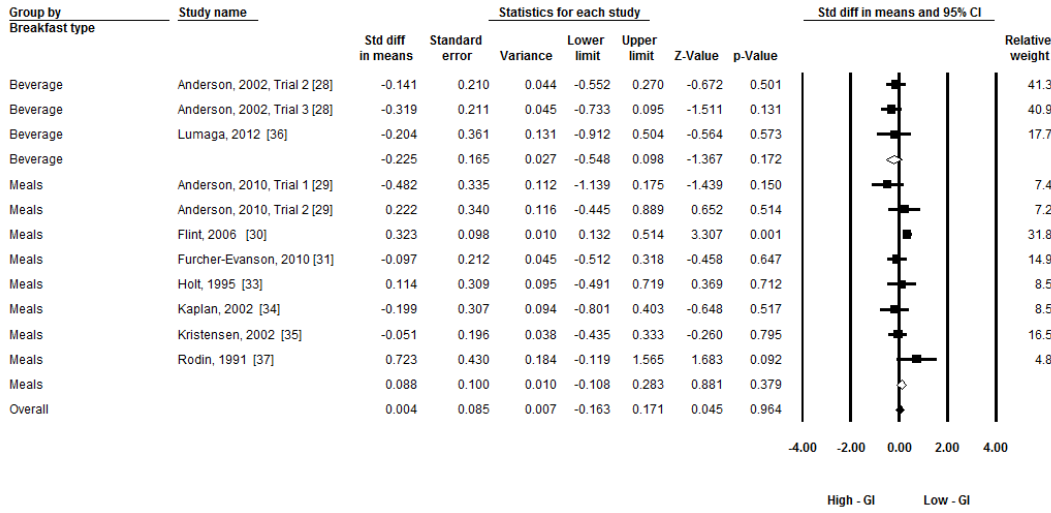
Figure 5. Subgroup meta ‐ analysis: The effect low ‐ GI and high ‐ GI breakfast with different types on subsequent energy intake. (GI: Glycemic Index).